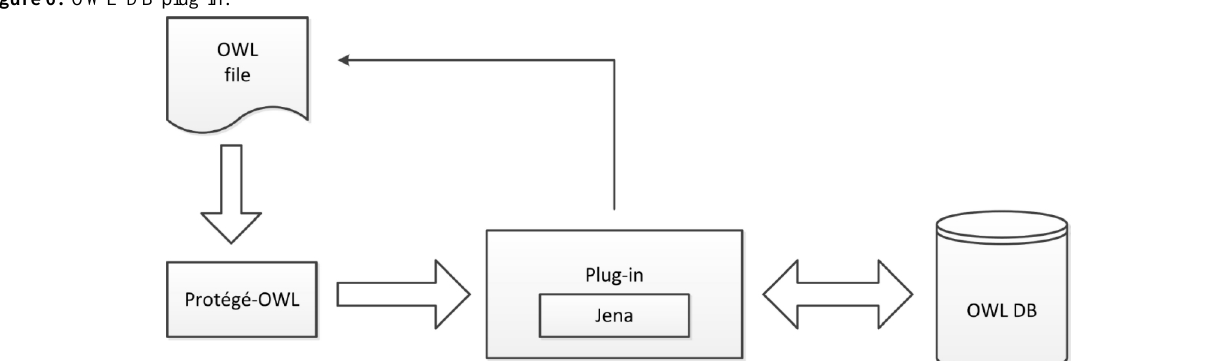
Figure 6. OWL-DB